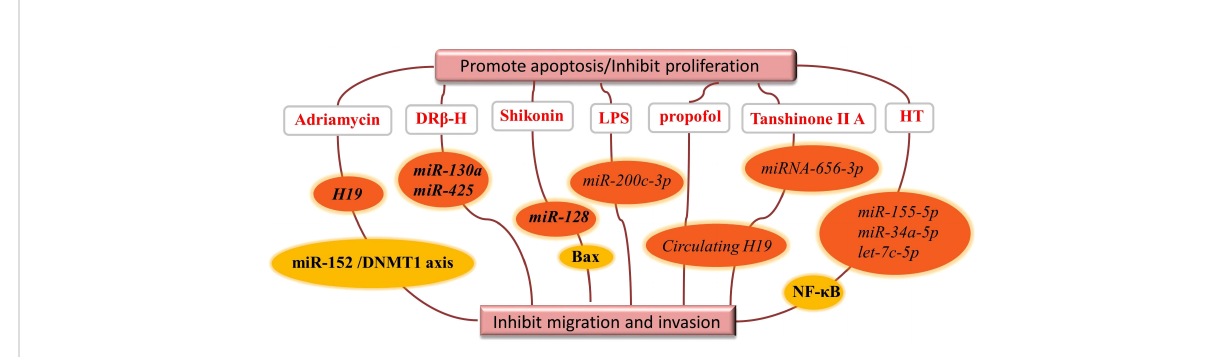
FIGURE 4 Natural drugs regulate exosomal ncRNAs to promote tumor cell apoptosis or